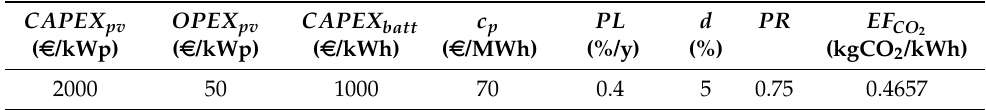
Table 1. Energy economic and environmental parameters used for calculating indicators in each raster cell [19,20,31–33].